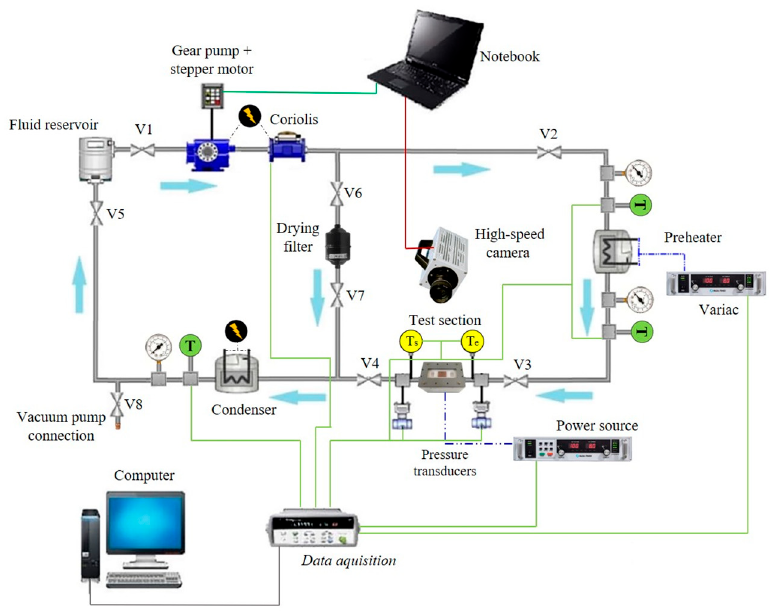
Figure 1. Schematic diagram of the experimental apparatus.